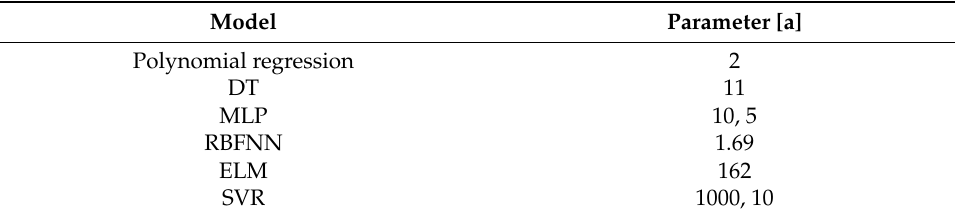
Table 7. Model parameters of different models in predicting